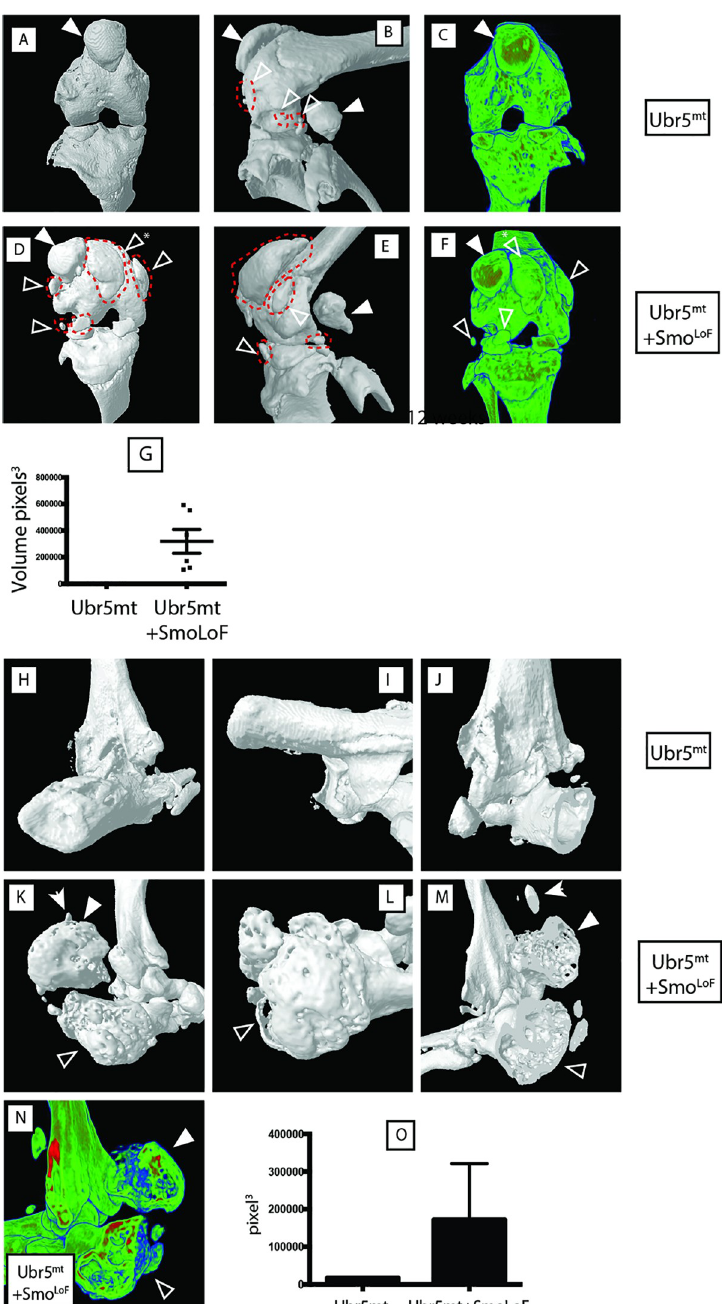
Fig 5. Smo LoF enhances the Ubr5 mt ECCO phenotype. Analysis of 12-week-old knee (A-G) and ankle (H-O) joints by μ CT-based 3D models. (A-C) Ubr5 mt and (D-F) Ubr5 mt + Smo LoF knee joints revealed ectopic structures marked by red dashed lines and open arrowheads. Sesamoid bones indicated by closed arrowhead. Asterisk marks an ectopic structure displacing the patella. Images (A, B, D, E) are surface rendered 3D models, while (C, F) are optical cross sections through the volume-rendered model revealing the internal structure and X-ray densities of the (open arrowhead) ectopic sesamoid and (closed arrowhead) abnormal patella structures. (G) Volumetric analysis of ectopic structures revealed Ubr5 mt + Smo LoF exhibited a dramatic increase in total ectopic volume over Ubr5 mt alone. Mean and s.e.m indicated. n = six knees from three animals for each genotype. t-test. p = 0.0002. (H-J) Ubr5 mt ankle joints exhibited a few small ectopic signals. (K-N) Ubr5 mt + Smo LoF ankles joints exhibited large (closed arrowhead) and small (arrow) ectopic signals in addition to an abnormal and enlarged calcaneus (open arrowhead). (N) Optical cross sections through volume-rendered model revealed the internal structure and X-ray densities of the (open